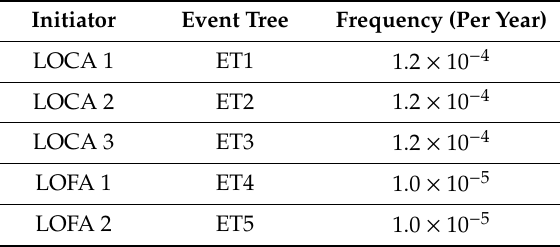
Table 8. Initiator frequency data of event tree